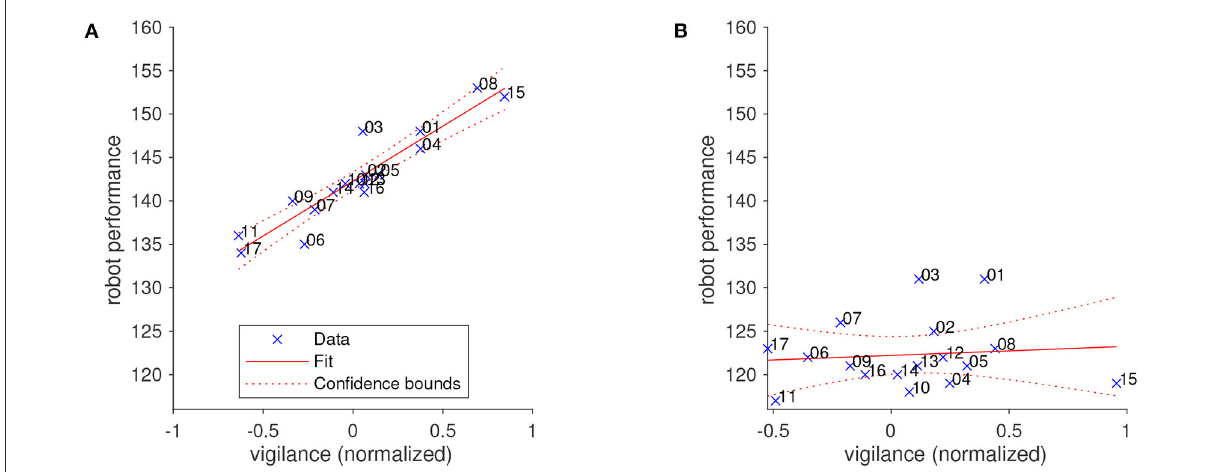
FIGURE11 The relationship between human vigilance and robot performance fitted by a linear model. (A) The robot’s velocity is controlled by the operator’s vigilance (BCI+VCV condition). (B) Robot velocity is not modulated by vigilance (BCI condition). Numbers at data points indicate participant